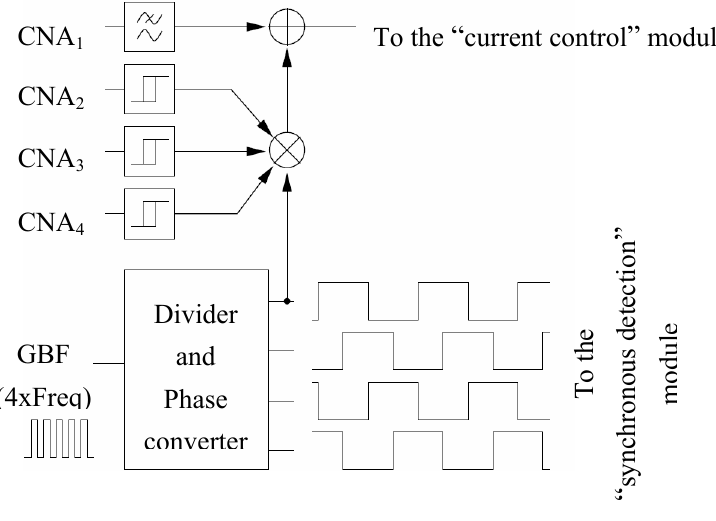
Figure 8. Schematic of the “Signals generator”